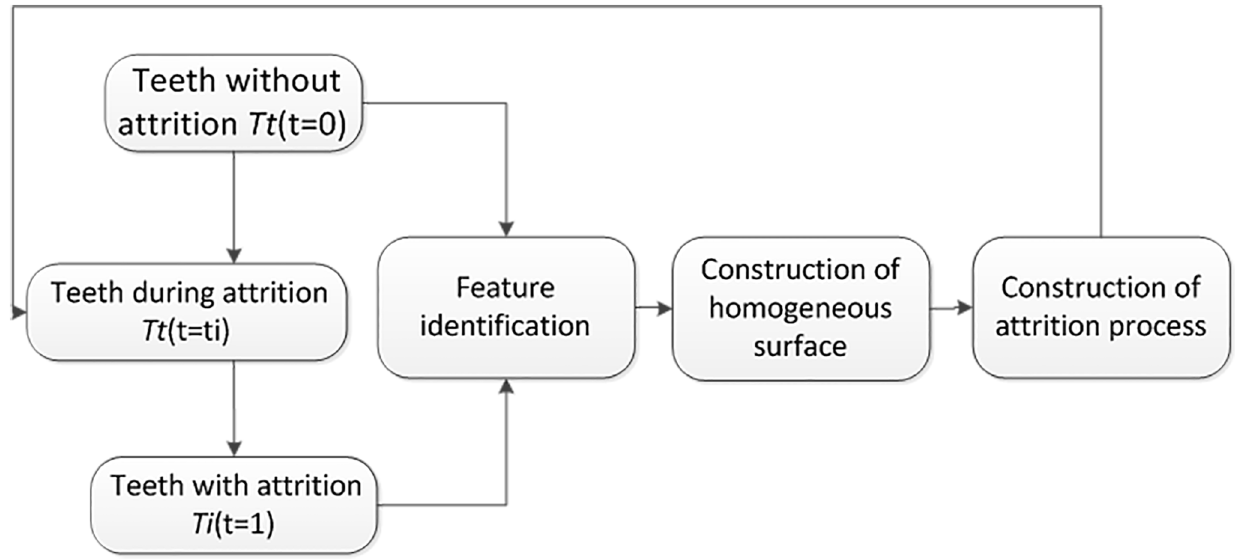
Fig 1. Simulation of the tooth wear process includes four stages: data acquisition, feature identification, construction of homogeneous surface and generation of attrition process model.